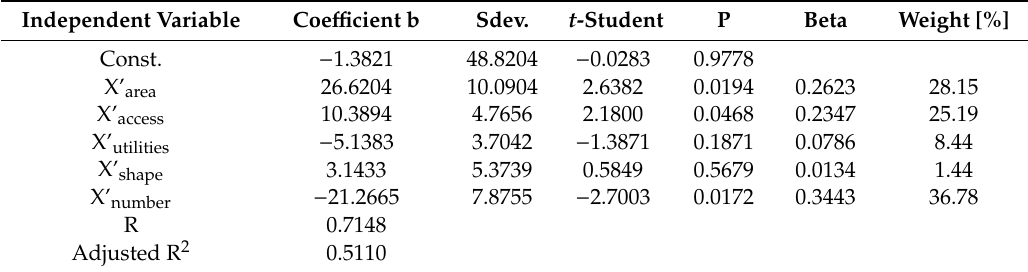
Table 4. Modeling results for determining the weight of individual attributes for the “ex post” condition. Independent